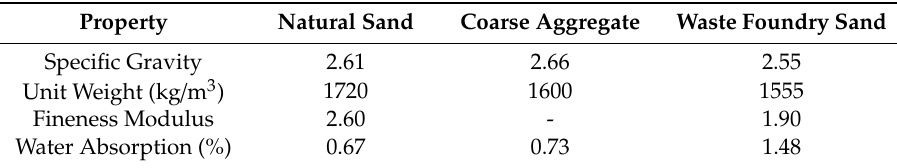
Table 3. Physical properties of aggregates.